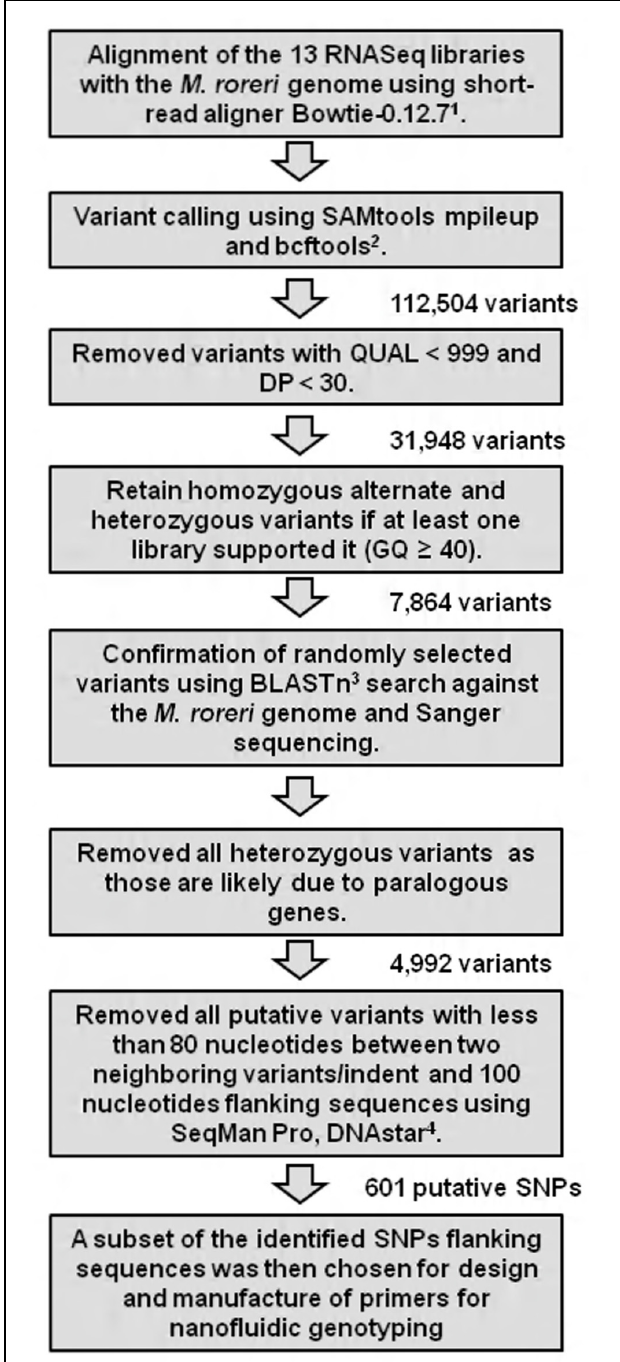
FIGURE 1 | The overview of the single nucleotide polymorphism (SNP) mining strategy from Moniliophthora roreri RNASequencing (RNASeq) libraries. Each library from M. roreri isolates Co17, Co7, E18, Co15, E16, E43, C13, Co12, Co8, Co11, E32, P1, and MCA2977 was aligned against the M. roreri genome (Meinhardt et al., 2014) and variant calling was performed. Reference for bioinformatics tools: 1 Langmead et al., 2009; 2 Li et al., 2009; 3 Larkin et al., 2007, and 4 DNASTAR, 1999. Abbreviation: QUAL (quality): Phred-scaled quality score for the assertion made in alternate base; DP: Combined depth across samples; GQ: Conditional genotype